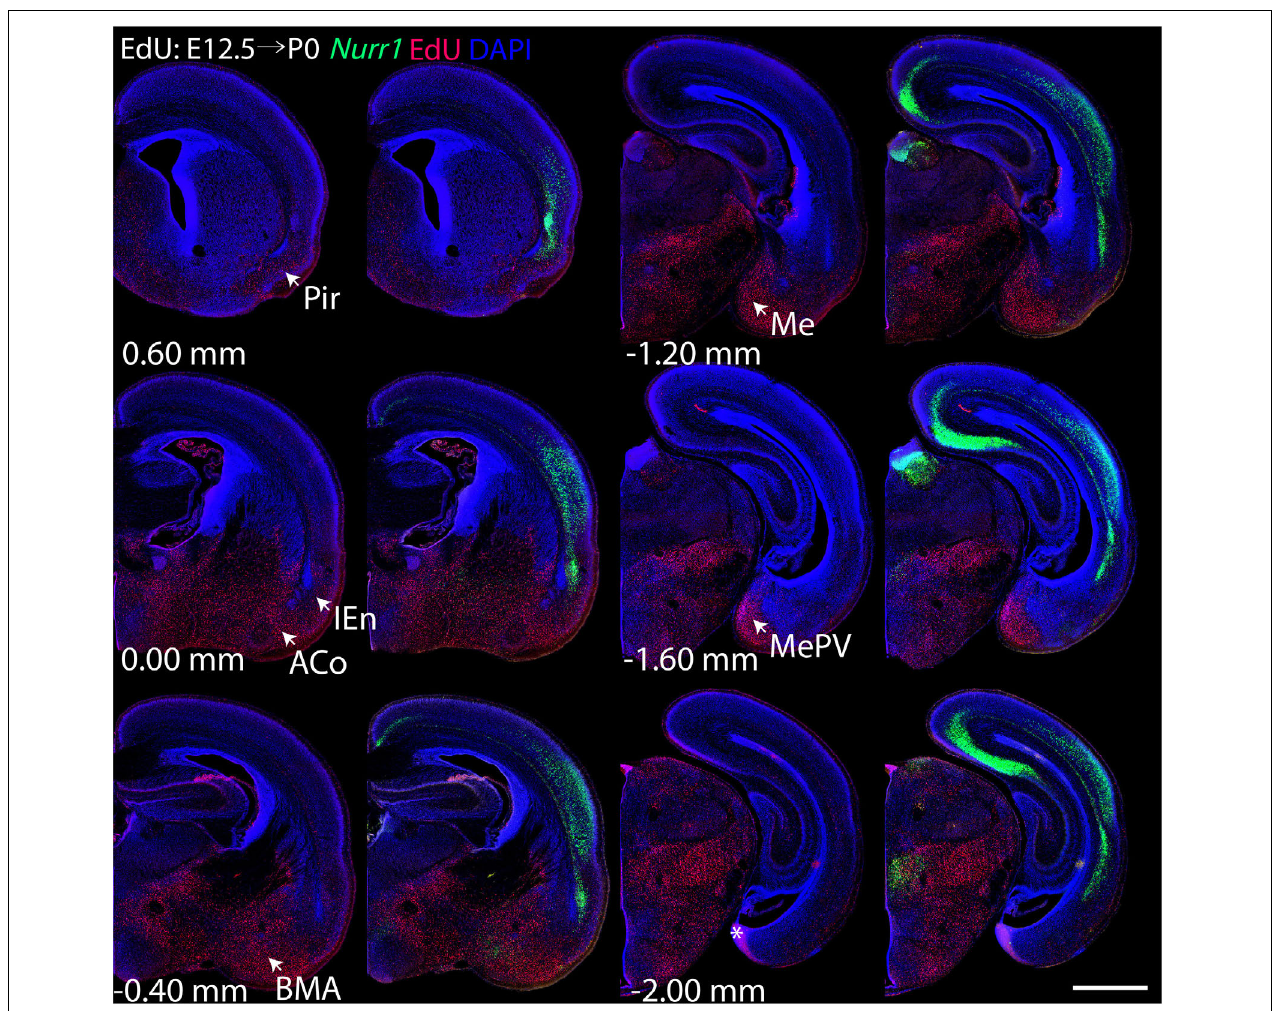
FIGURE 4 | Overview of EdU labeling on E12.5 with Nurr1 FISH on P0. White arrows indicate EdU labeled regions. Pir, piriform cortex, IEn, intermediate endopiriform nucleus, ACo,anterior cortical amygdaloid area, BMA, basomedial amygdaloid nucleus, anterior part, Me, medial amygdaloid nucleus, MePV, medial amygdaloid nucleus, posteroventral part. Numbers below sections indicate the bregma coordinate. N = 3 rats. “ ∗ ” indicates staining artifacts. Scale bar = 1